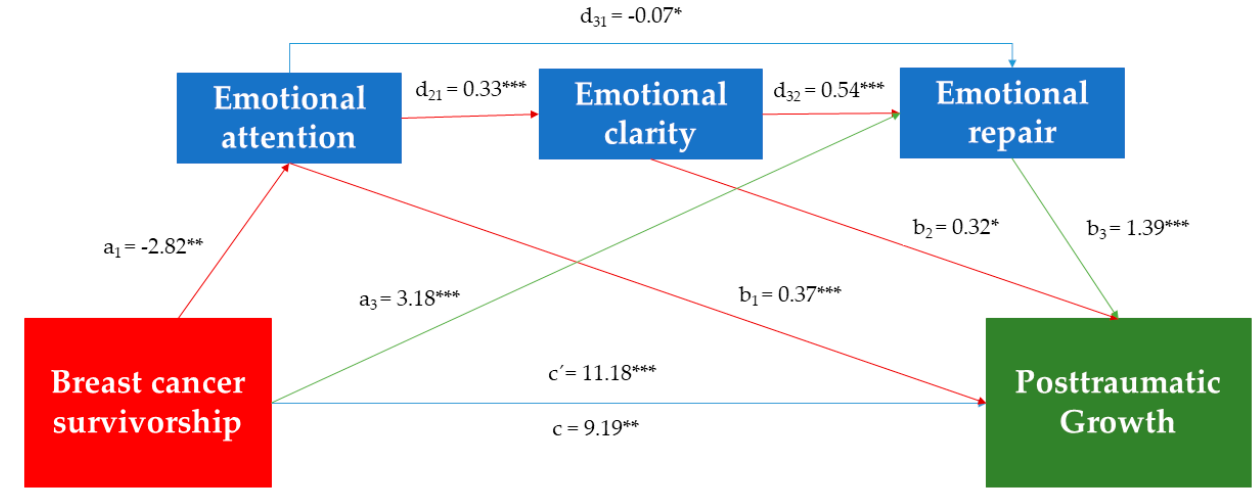
Figure 4. Direct and indirect effects for mediation model. Notes. * p < 0.05; ** p < 0.01; *** p < 0.001.